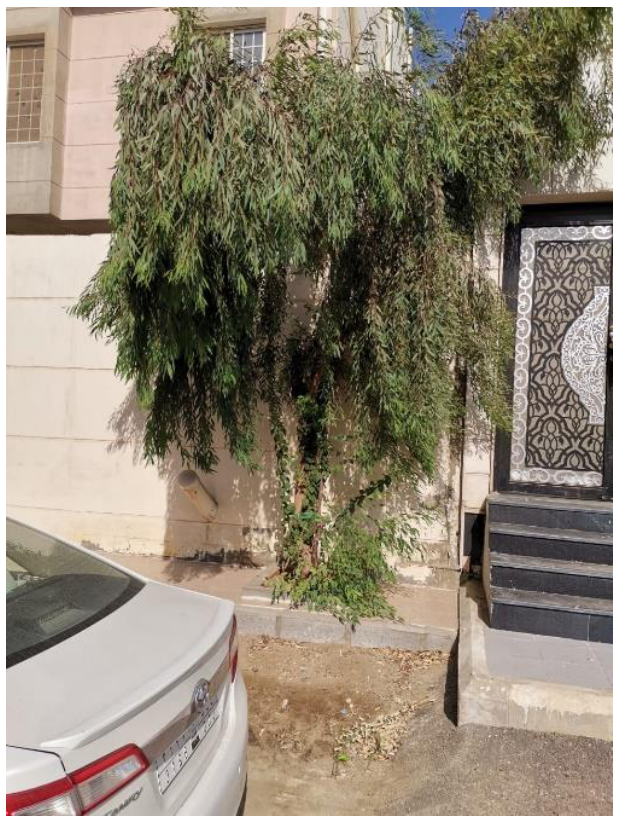
Fig. 3. Eucalyptus tree planted in Jeddah in 2019 The tree has proven a high ability to live in the environment of the city of Jeddah (humid and hot). The tree was growing fast and every time some branches were cut, it was noticed that it was growing again quickly. The tree has reached more than 4 m in length in less than one year, and the tree has resisted pollution and harsh environmental conditions with unparalleled success, which made me suggest planting the tree to solve the problem of wastewater leakage in the Khulais